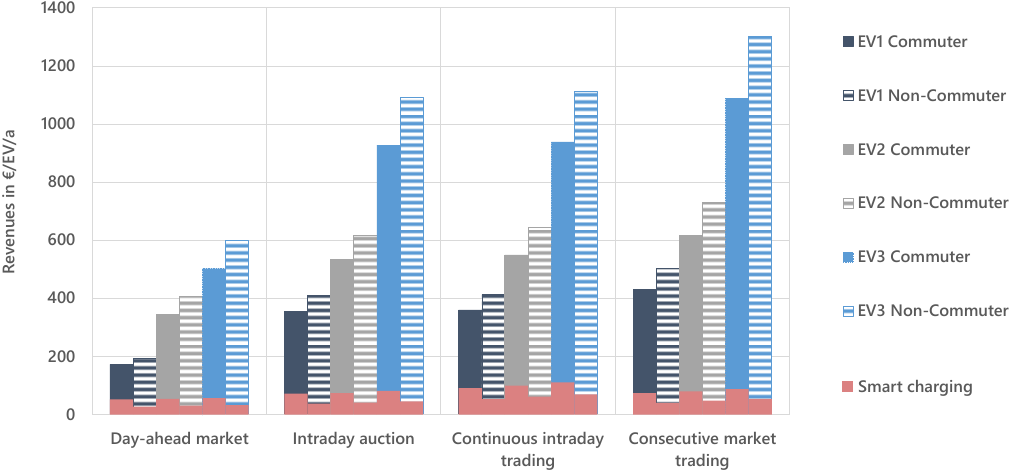
Figure 3. Revenues for bidirectionally chargeable and smart charging EVs participating in different spot markets in Germany.